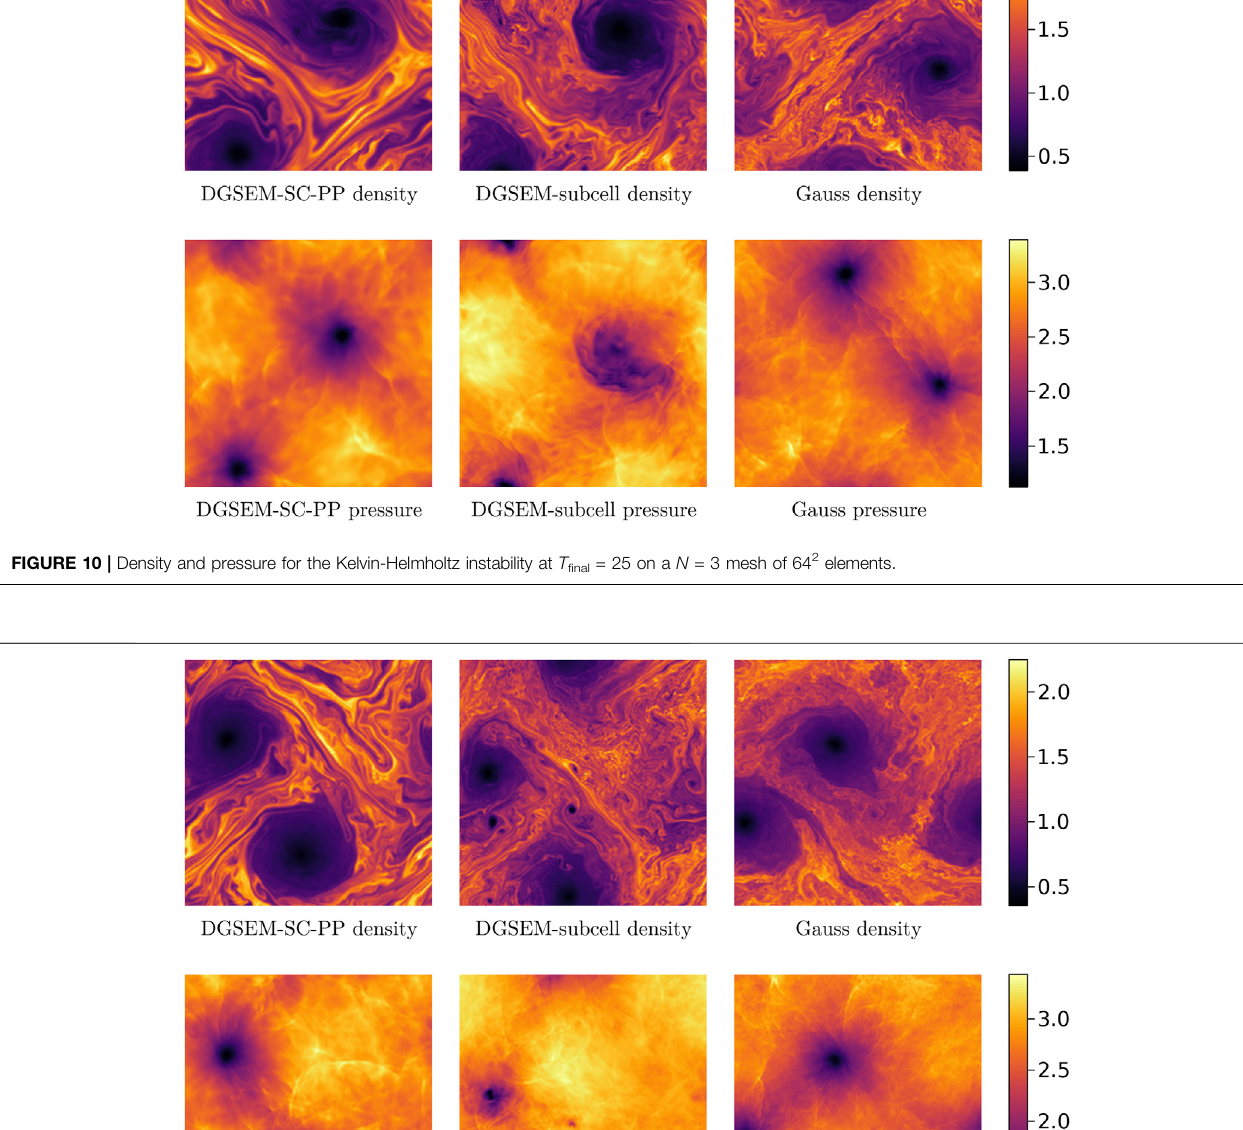
Frontiers in Physics |